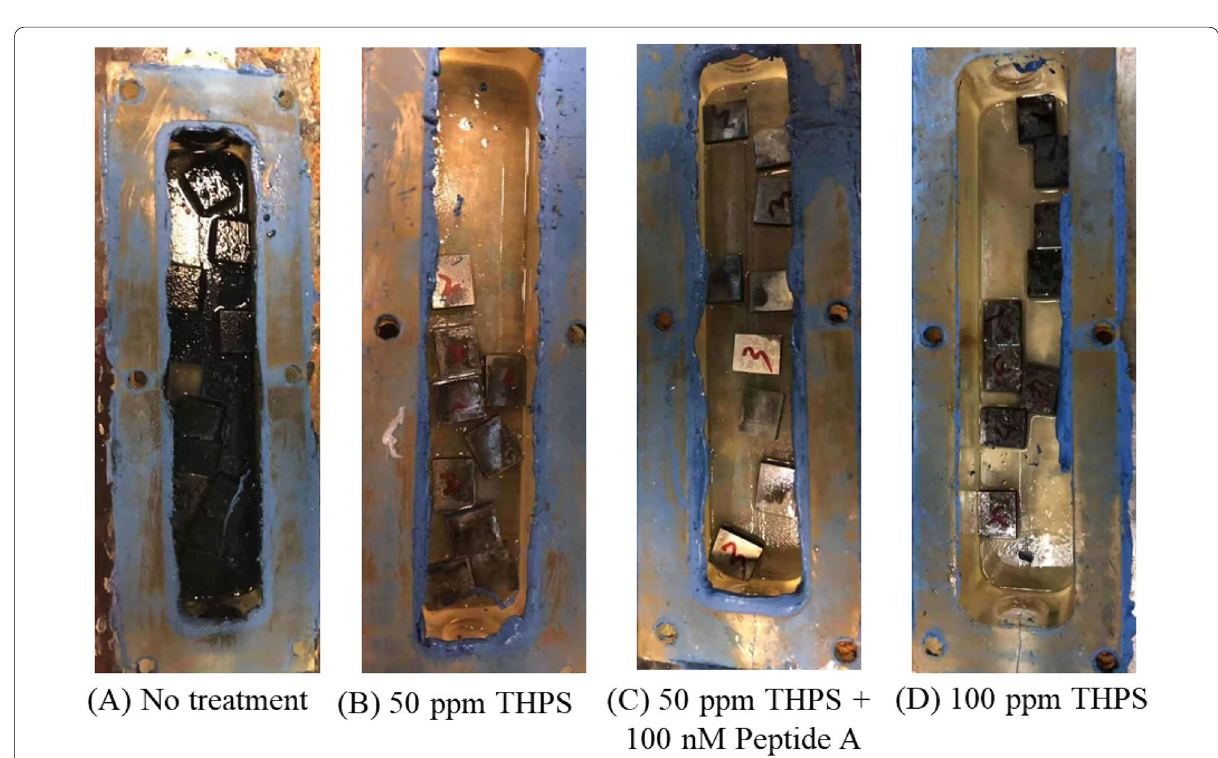
Fig. 4 Coupon surfaces after 7-day incubation with different biocide